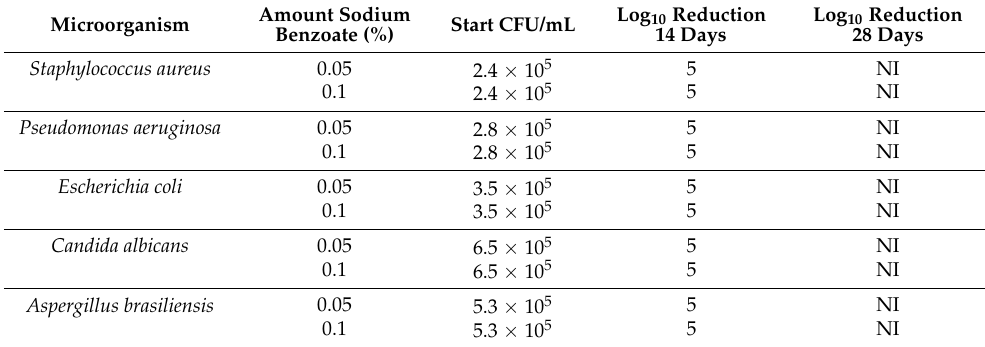
Table 10. Microbiological challenge test for Propranolol 10 mg/mL with preservative sodium ben- zoate. Results expressed as log 10 reduction after 14 and 28